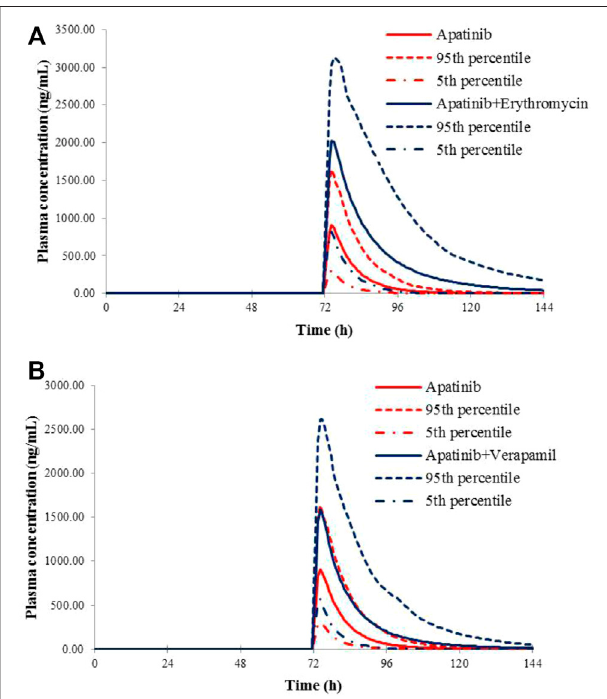
FIGURE 4 | Predicted mean plasma concentration – time curves of apatinib withor withoutco-administration ofCYP3A4inhibitors,erythromycin (A) , and verapamil (B)